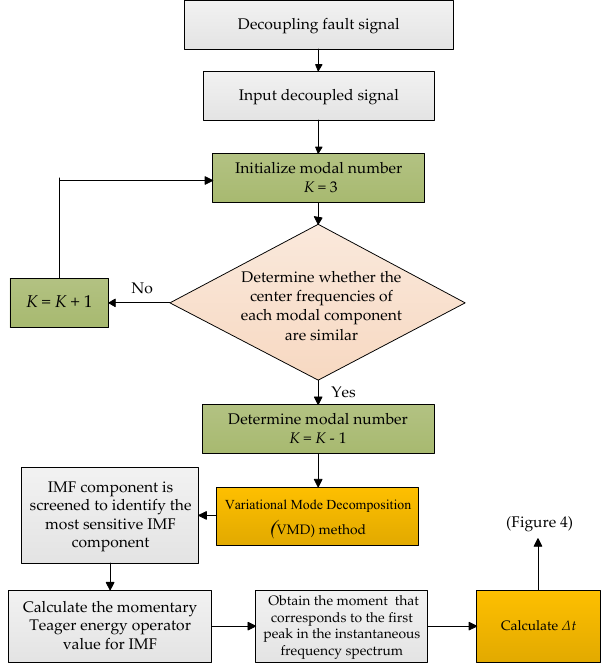
Figure 5. Process of fault location based on variational mode decomposition (VMD) and the Teager energy operator (TEO).